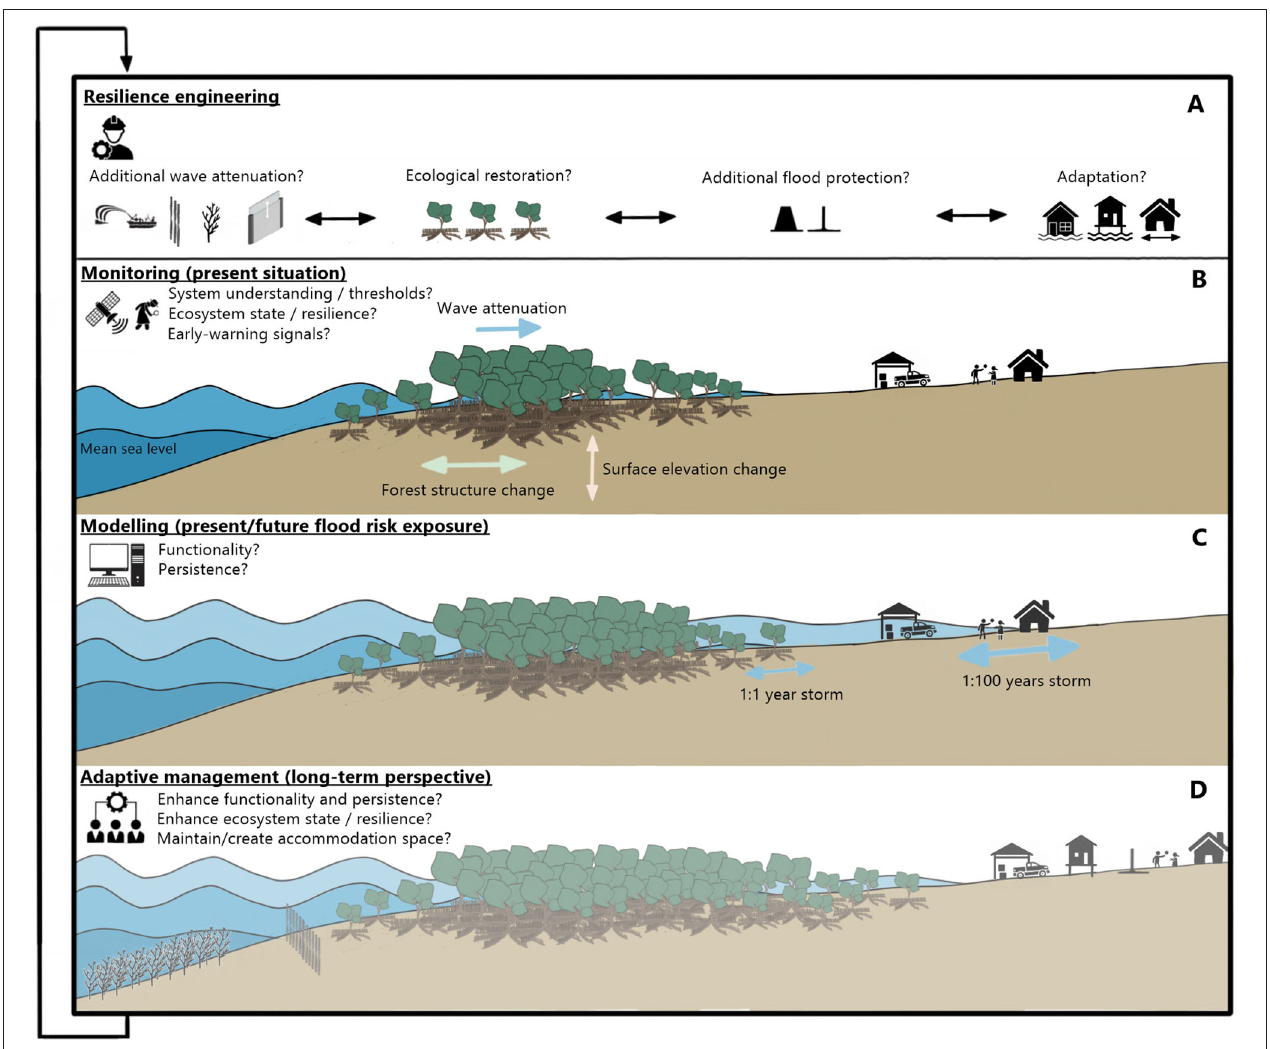
FIGURE 7 | Schematic overview of an adaptive management approach with (A) (temporary) engineering interventions, in which humans enhance and adapt to the functionality and persistence of the mangroves. The mangroves are (B) monitored, (C) their functionality and persistence are assessed and predicted to determine the necessity of (temporary) engineering interventions within (D) a long-term perspective to reduce coastal flood risk with mangroves. The uncertainty of flooding events due to the variability in mangrove functionality and the uncertainty of monitoring and modelling tools is indicated with the blue arrows in (C)